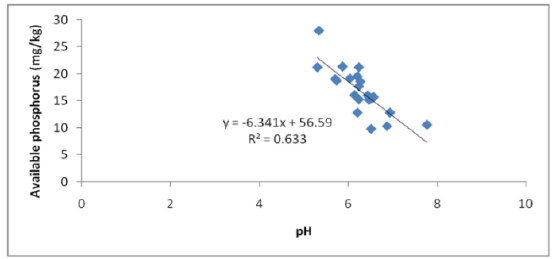
Figure 2 : The relationship between nitrogen content and the soil pH Relationship between soil pH and available phosphorus: - The soil pH and plant available phosphorus content had negative correlation (r= -0.796**) with each other. The coefficient of determination (R 2 =0.633) indicated that the contribution of SOM content to the available phosphorus was 63.3% and rest of the effects was due to other factors which is shown Figure 3. Soil organic matter had significant effect on phosphorus availability.